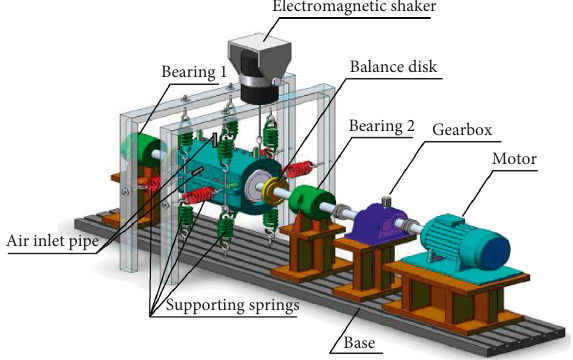
Figure 3: Schematic diagram of seal test